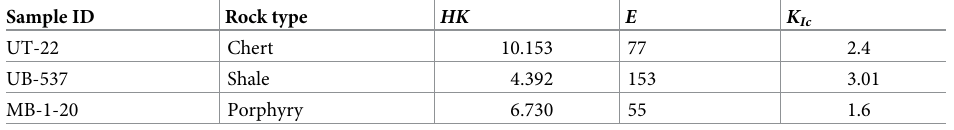
Table 2. Hardness (HK), elasticity (E), and fracture resistance (KIc) values as calculated from the indentation tests.